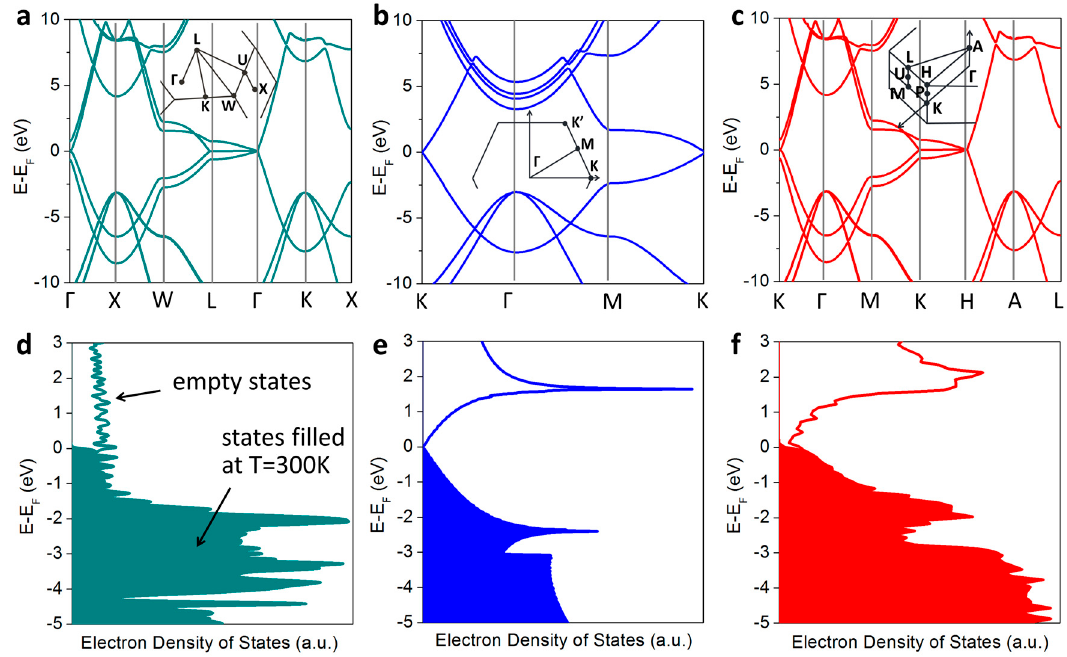
Figure 2. ( a – c ) Electron band structures of gold ( a ); graphene ( b ) and graphite ( c ) calculated by using the first-principles DFT method. The insets show the irreducible wedges of the Brillouin zones and the high-symmetry points in the reciprocal space of each crystal lattice; ( d – f ) The electron population of available energy states in the dark at T = 300 K (filled curves) and the density of electron states available for the upward electron transitions (empty curves) for Au ( d ), graphene ( e ) and graphite ( f ). Table 1. Parameters used in the DFT calculations of the electron density of states.